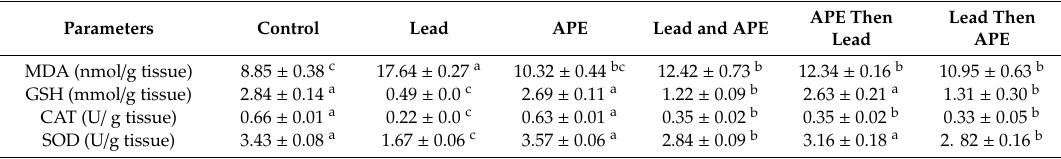
Table 5. E ff ect of lead and / or Azolla Pinnata ethanolic extract (APE) on lipid peroxidation and antioxidant biomarkers in hepatic tissues in rats.